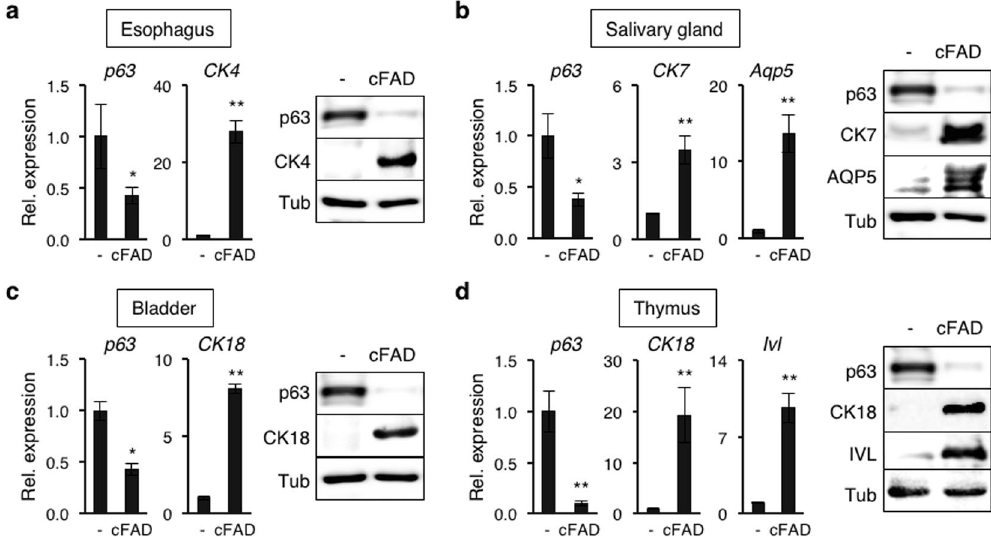
Figure 6. Mouse epithelial progenitor cells expanded by TGF- β inhibition are capable of differentiation in vitro . ( a – d ) Newborn mouse-derived epithelial progenitor cells expanded by RepSox treatment were grown in CnT-PR media in the presence of 1 μ M RepSox to sub-confluence, followed by cultivation in cFAD for 7 days in the absence of RepSox. Epithelial progenitor cells used were derived from the ( a ) esophagus, ( b ) salivary gland, ( c ) bladder, and ( d ) thymus. Bar graphs on the left , quantitative RT-PCR analysis of epithelial cell differentiation marker genes, p63 , CK4 , CK7 , CK18 , Ivl , and Aqp5 . Data shown are normalized to the housekeeping gene Gapdh and expressed as mean ± s.e.m. (n = 3). * P < 0.05; ** P < 0.01. Right , Western blot analysis with antibodies against p63, CK4, CK7, CK18, aquaporin 5 (AQP5), and involucrin (IVL). Tubulin- α (Tub) was used as a loading control. The full-length blots are included in Supplementary Figure